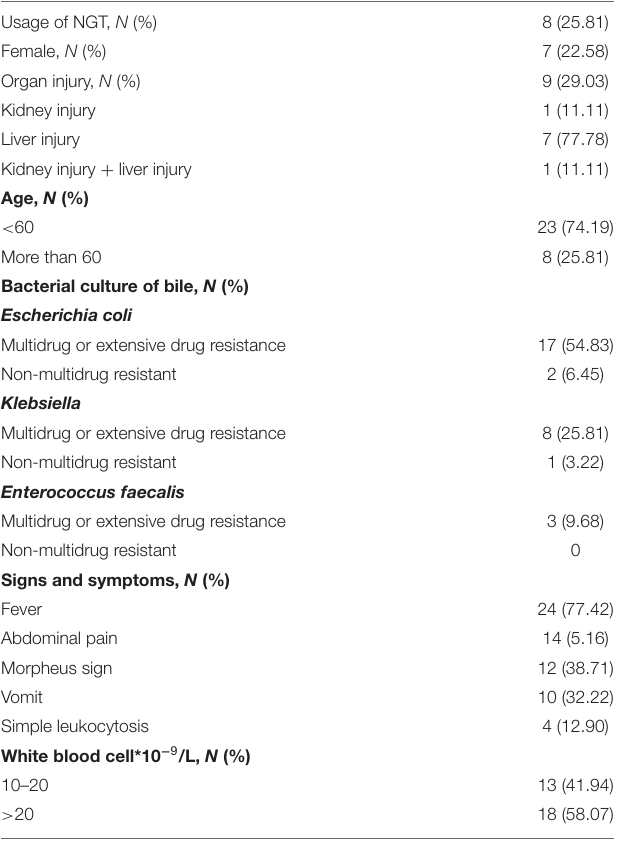
TABLE 4 | Characteristics of patients with